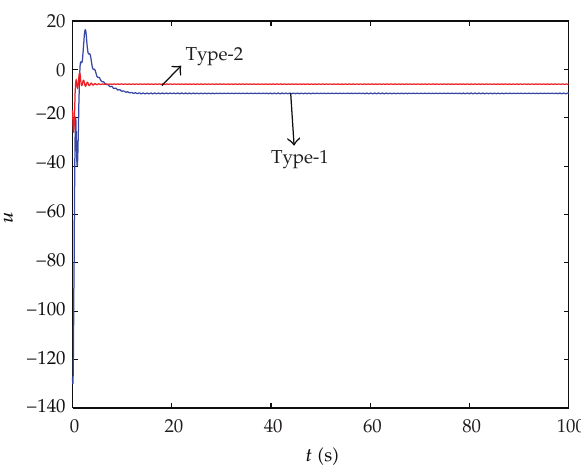
Figure 4: Trajectories of